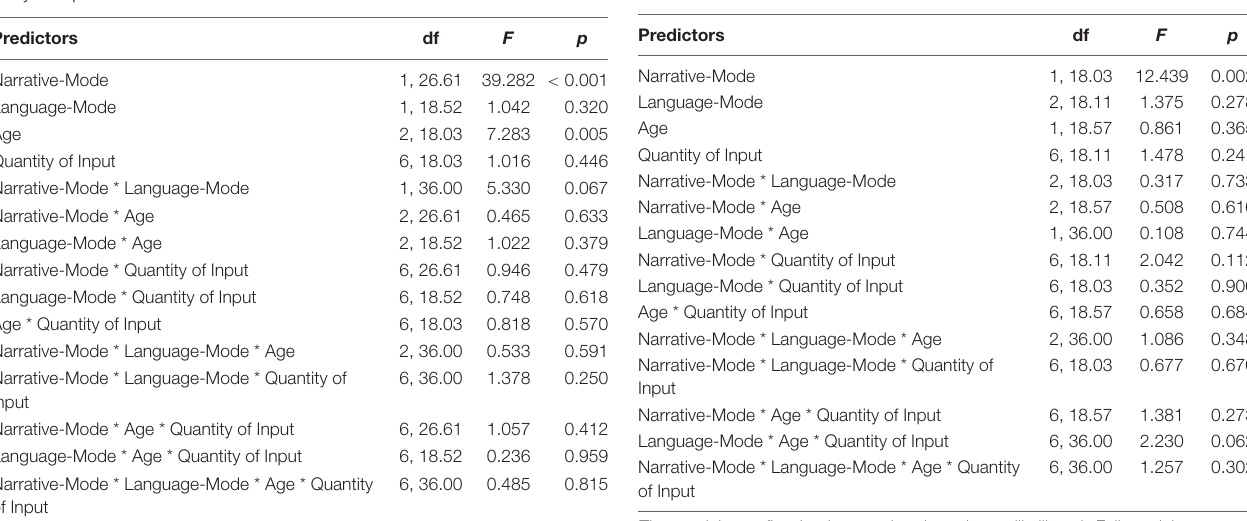
TABLE 7 | Results of the linear mixed model for the dependent variable Number of Utterances.